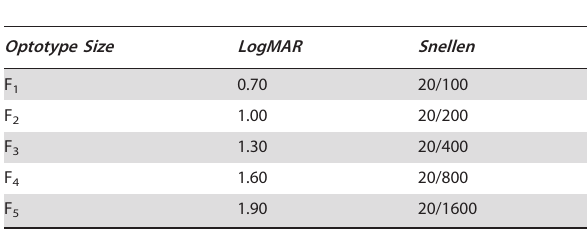
Table 1. Primary experiment optotype sizes.